Question: Provide a one-line summary of what is displayed.
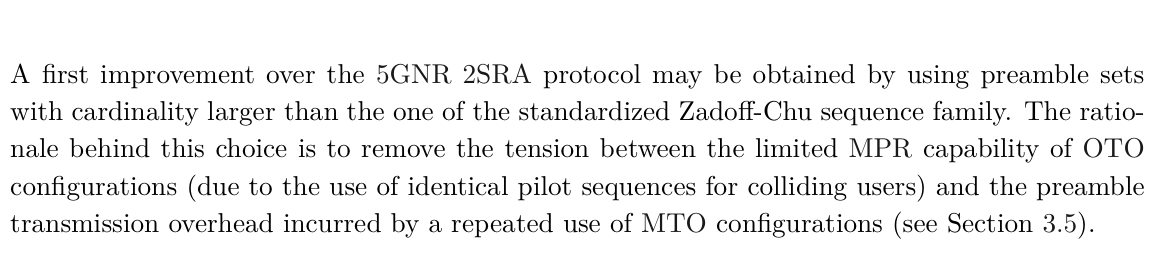
Answer: reports the performance achievable over the quasi-static fading MAC by enlarging the preamble set to 1024 ( ), 8192 ( ), and 16384 ( ) preambles. In all three cases, non- orthogonal preambles with symbols drawn independently from a complex Gaussian distribution were used. The preamble length has been fixed to the one used in the 2SRA simulations (see Section 3.1), i.e., nPRE = 2 × 139 c.c.u.s. Each preamble points one of the N = 64 POs, realizing a MTO configuration, and to a unique pilot sequence. The rest of the configuration parameters is unmodified with respect to Table 1. The result with 1024 preambles shows a remarkable gain over the OTO mapping configuration with 64 preambles: the number of active users supported by the system is multiplied by a factor four. The improvement over the MTO configuration with 64 preambles is remarkable, too, although limited to a 50% gain in the number of supported users.